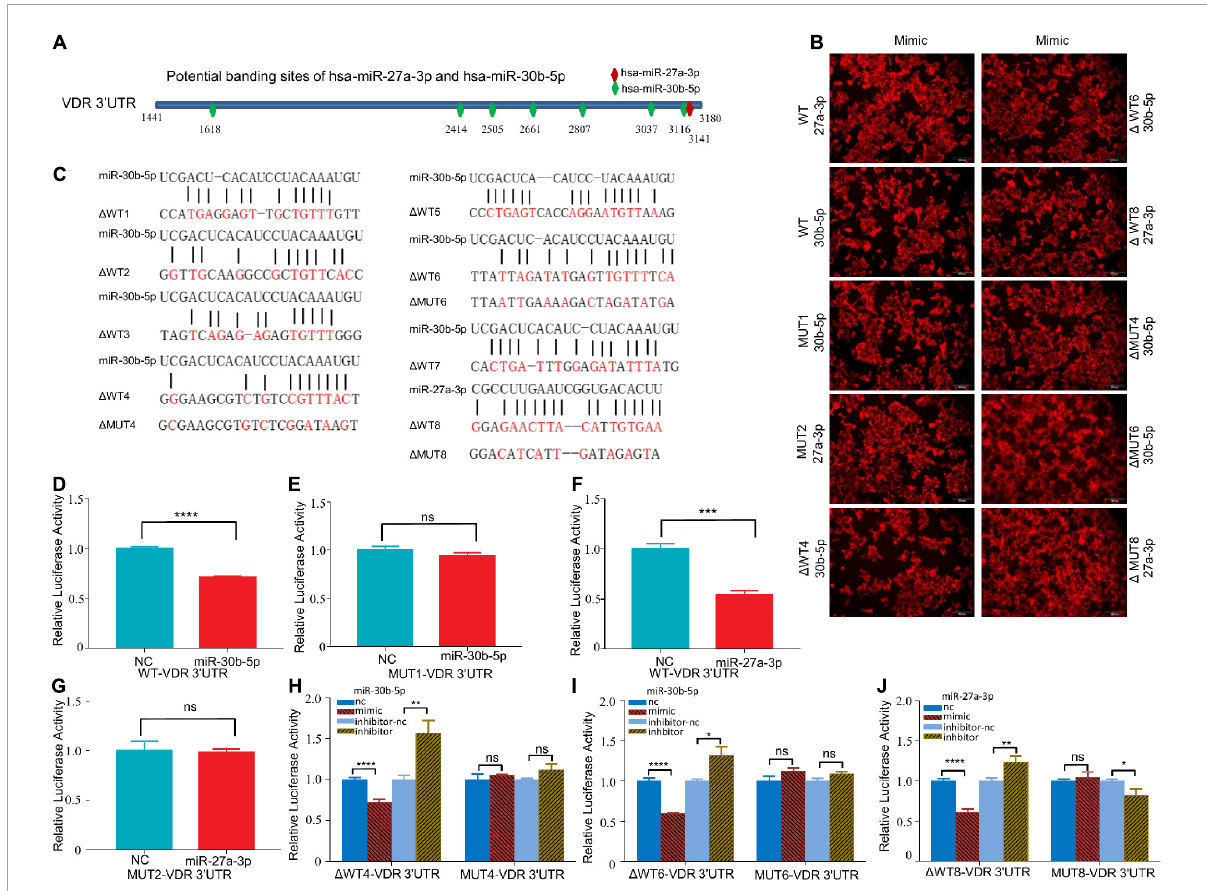
FIGURE5 MiR-27a-3p and miR-30b-5p could bind to the 3 (cid:48) UTR of VDR mRNA. (A) The potential binding sites of miR-27a-3p and miR-30b-5p in the 3 (cid:48) UTR of VDR mRNA were predicted with the ENCORI database. (B) Red fluorescence was observed by fluorescence microscopy 48 h after transfection of HEK-293T with miR-27a-3p-Cy-5 and miR-30b-5p-Cy-5 mimics. (C) The sequences of the two miRNAs, wild-type plasmids and mutant-type plasmids. (D,E) The relative luciferase activity of the WT/MUT1-VDR-3 (cid:48) UTR-pmirGLO plasmid after miR-30b-5p overexpression. (F,G) The relative luciferase activity of the WT/MUT2- VDR-3 (cid:48) UTR-pmirGLO plasmids after miR-27a-3p overexpression. (H) The relative luciferase activity of the (cid:49) WT4-VDR-3 (cid:48) UTR-pmirGLO plasmids and MUT4-VDR-3 (cid:48) UTR-pmirGLO plasmids after miR-30b-5p overexpression or knock down. (I) The relative luciferase activity of the (cid:49) WT6-VDR-3 (cid:48) UTR-pmirGLO plasmids and MUT6-VDR-3 (cid:48) UTR-pmirGLO plasmids after miR-30b-5p overexpression or knock down. (J) The relative luciferase activity of the (cid:49) WT8-VDR-3 (cid:48) UTR-pmirGLO plasmids and MUT8-VDR-3 (cid:48) UTR-pmirGLO plasmids after miR-27a-3p overexpression or knock down. * P < 0.05, ** P < 0.01, *** P < 0.001, **** P < 0.0001, ns = not